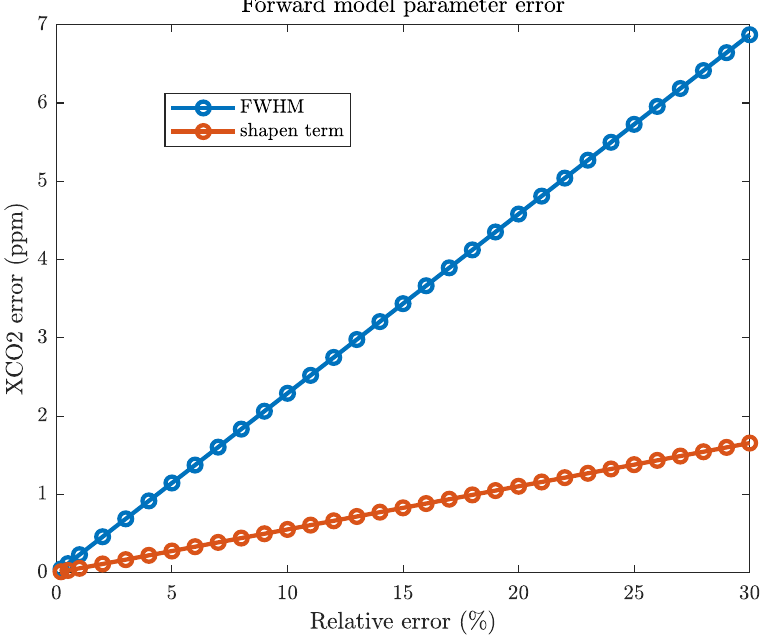
Figure 11. Estimation of XCO2 retrieval error due to FWHM and sharpen term uncertainties using synthetic TanSat measurements. Reflectance was modeled with: surface albedo = 0.05, solar zenith angle = 30, and viewing zenith angle =